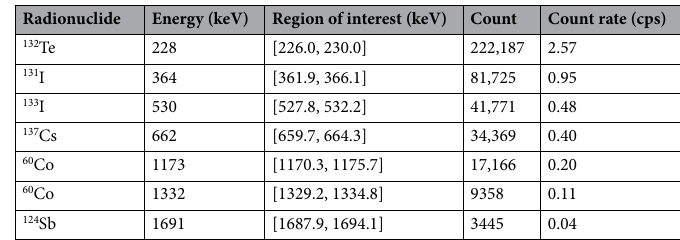
Table 5. Background measurement results of different energy γ-ray.